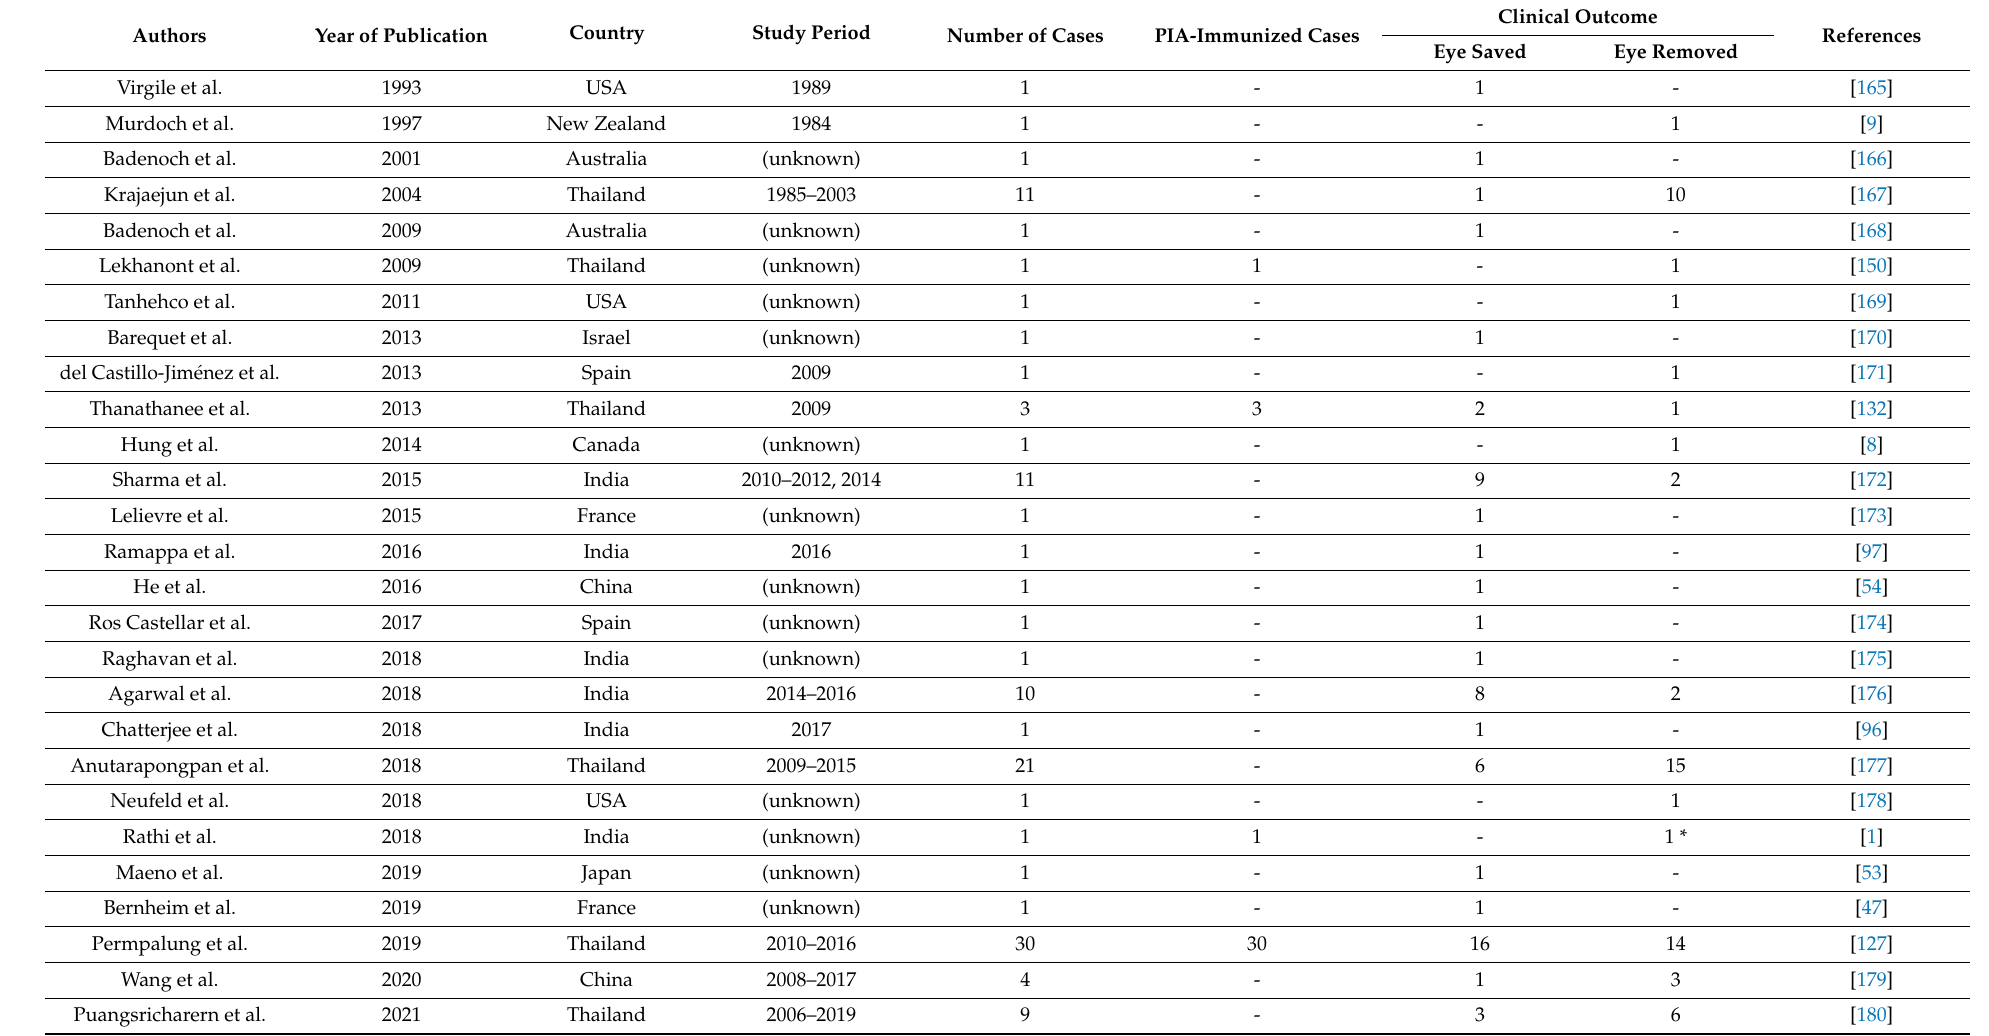
Table 2. Ocular pythiosis patients (168 cases) with or without the P. insidiosum antigen (PIA) immunotherapy, reported in the literature during